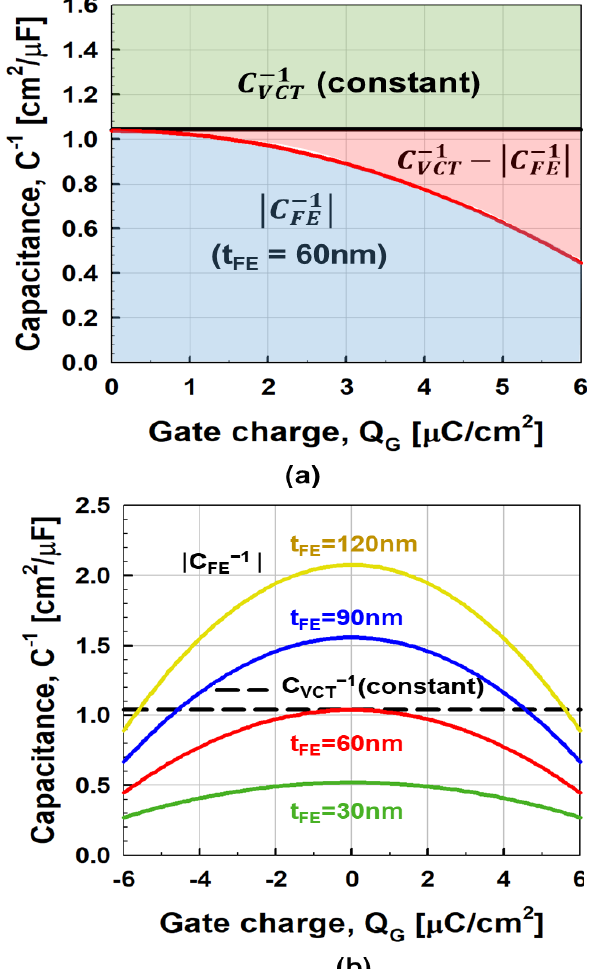
Figure 7. Comparison of vacuum channel transistor capacitance vs. ferroelectric capacitance as function of Q G for ( a ) ferroelectric thickness ( t FE ) is 60 nm, and ( b ) various ferroelectric thicknesses ( t FE = 30 nm, 60 nm, 90 nm, and 120 nm). The calculated capacitances are according LK model.